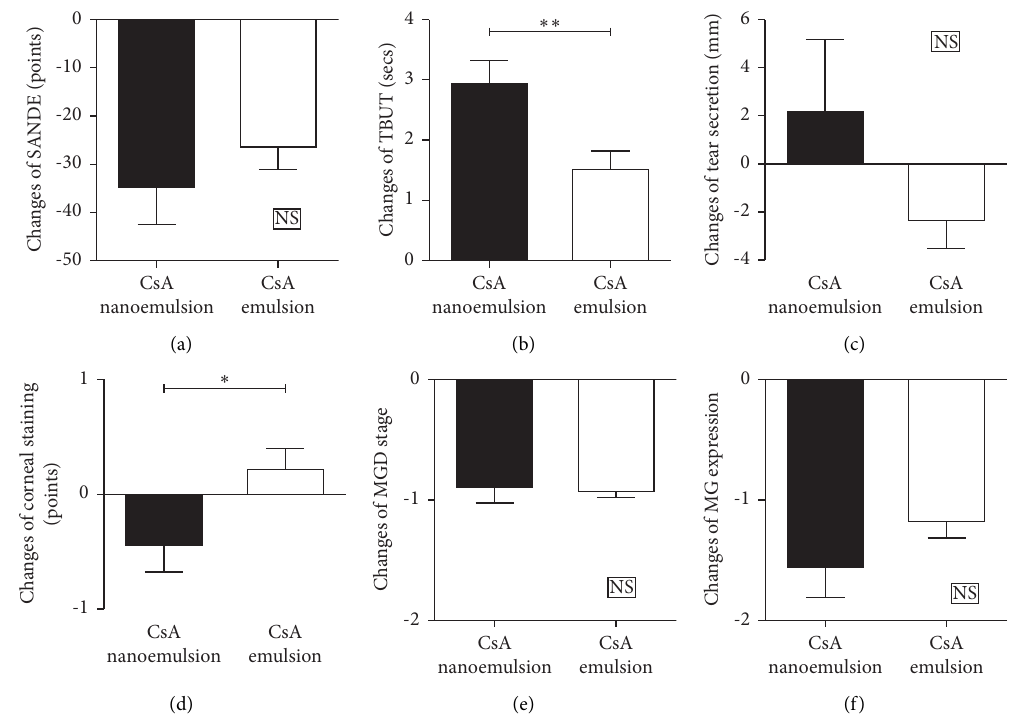
Figure 2: Comparison of changes in dry eye parameters between nanoemulsion and emulsion CsA groups at 12 weeks after treatment with initial topical steroid and consecutive topical CsA compared to baseline. CsA, cyclosporin; SANDE, symptom assessment in dry eye; TBUT, tear film breakup time; MGD, meibomian gland dysfunction; MG, meibomian